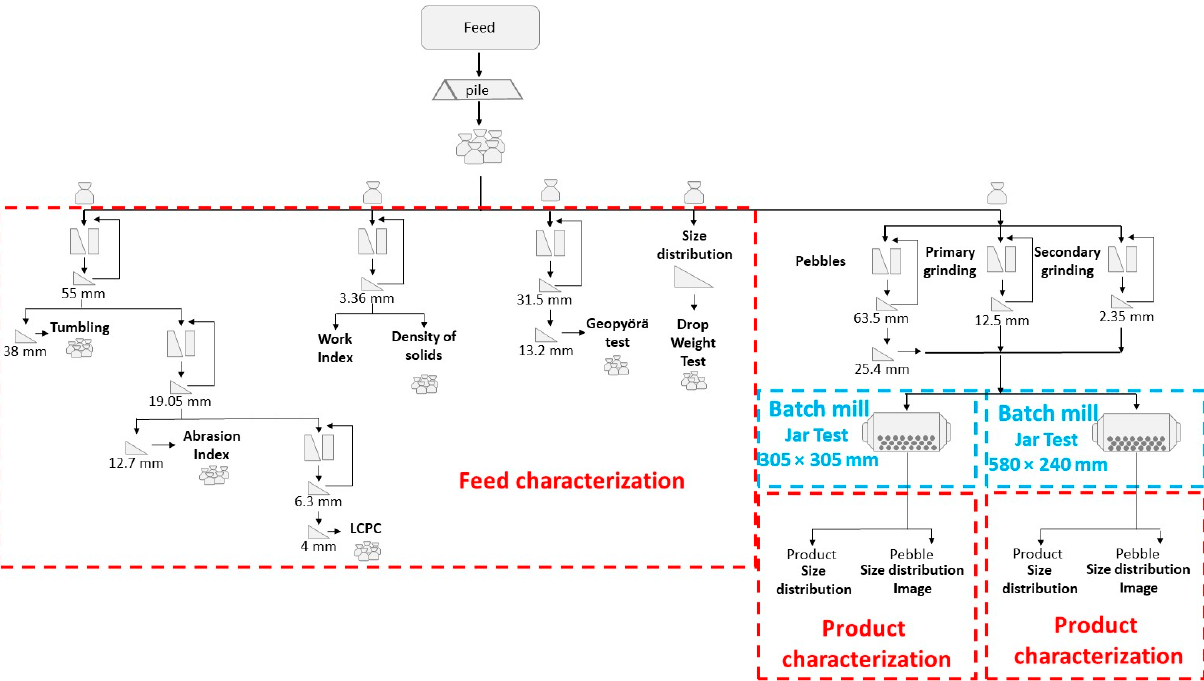
Figure 1. Test flowchart.